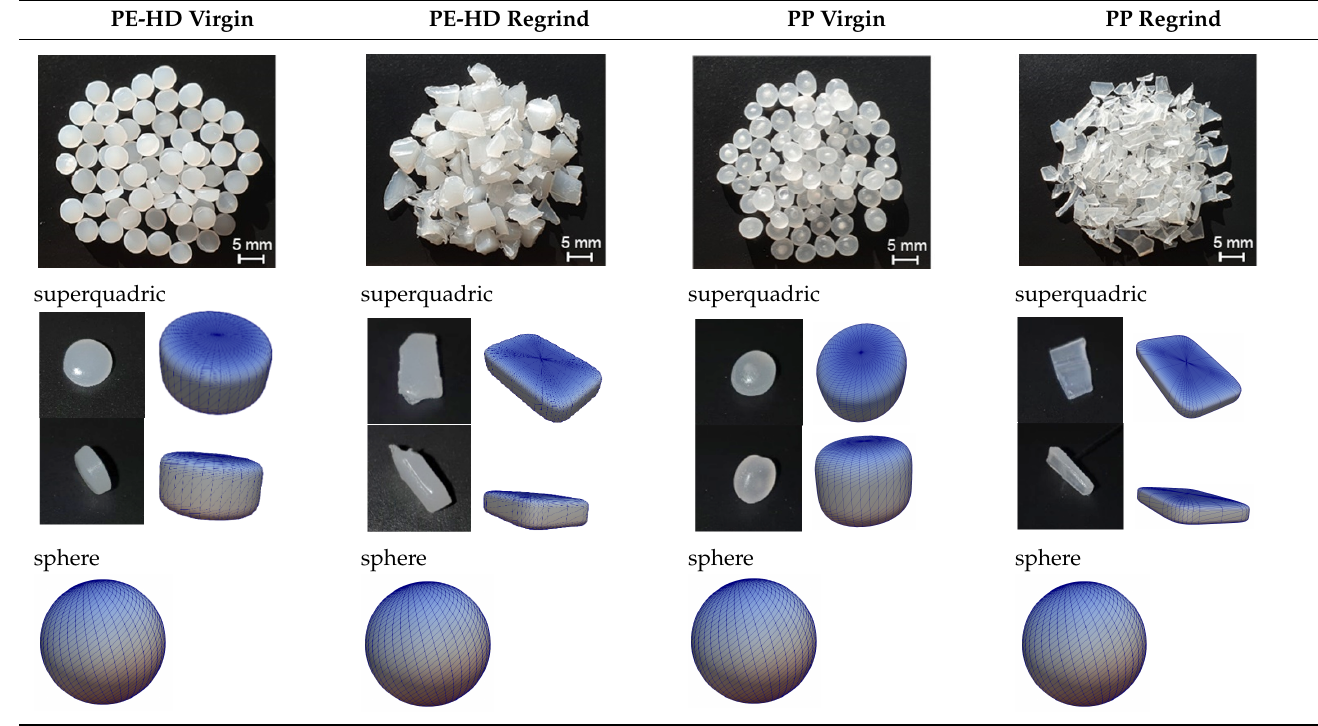
Table 1. Overview of applied materials and particle geometry transformation in the numerical simulation environment.